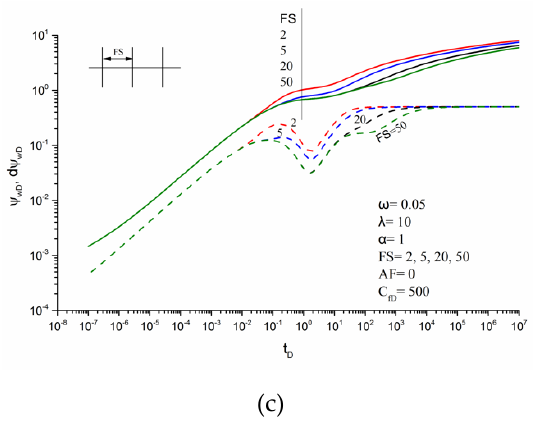
Figure 10. The typical pseudo-pressure curves of a multi-fractured horizontal well with different fracture spacing. (a) low conductivity; (b) intermediate conductivity; (c) high conductivity.